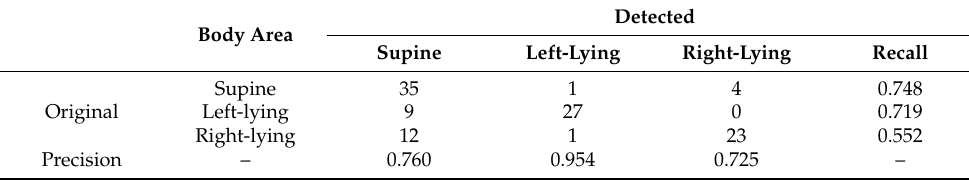
Figure 12. The body sensors. Table 3. The force-sensitive sensor of body detection.